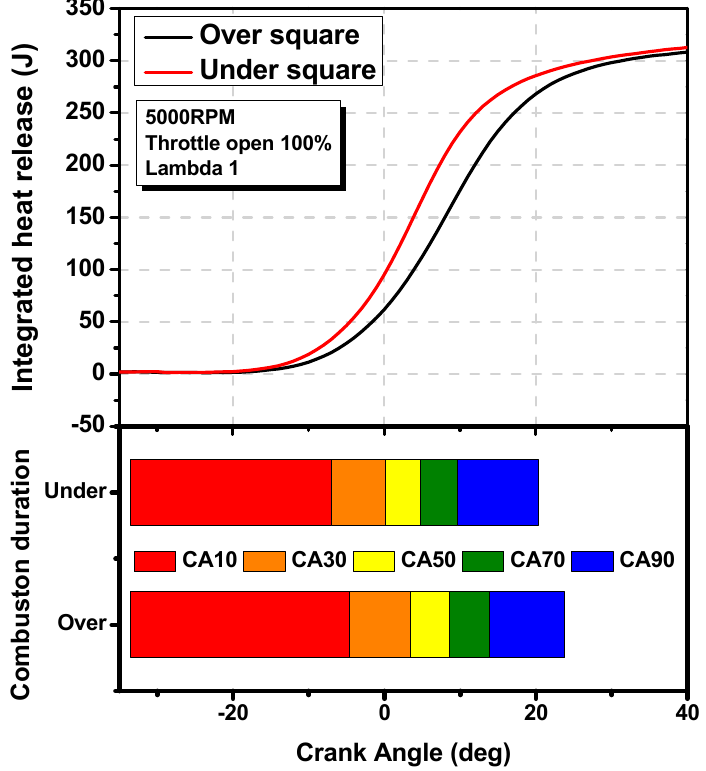
Figure 4. Integrated heat release and combustion duration for over- and under-square engines .